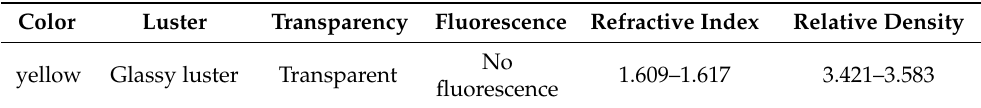
Table 1. The conventional gemological characteristics of yellow topaz.